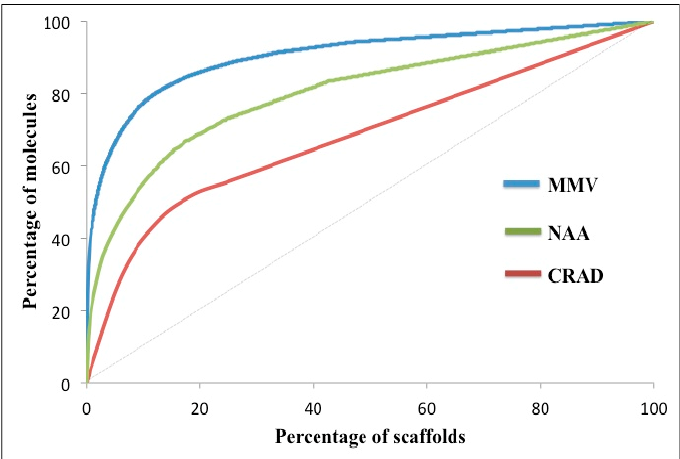
Figure 2. Cumulative Scaffold Frequency Plots of Murcko scaffolds from datasets. The plot is shown for currently registered antimalarial drugs (CRAD), natural products with in vitro antiplasmodial activity (NAA) and malarial screen data from Medicines for Malaria Venture (MMV). The closer the curve is to the diagonal line, the greater the scaffold diversity of the data set. Murcko scaffolds from CRAD showed the highest scaffold diversity.